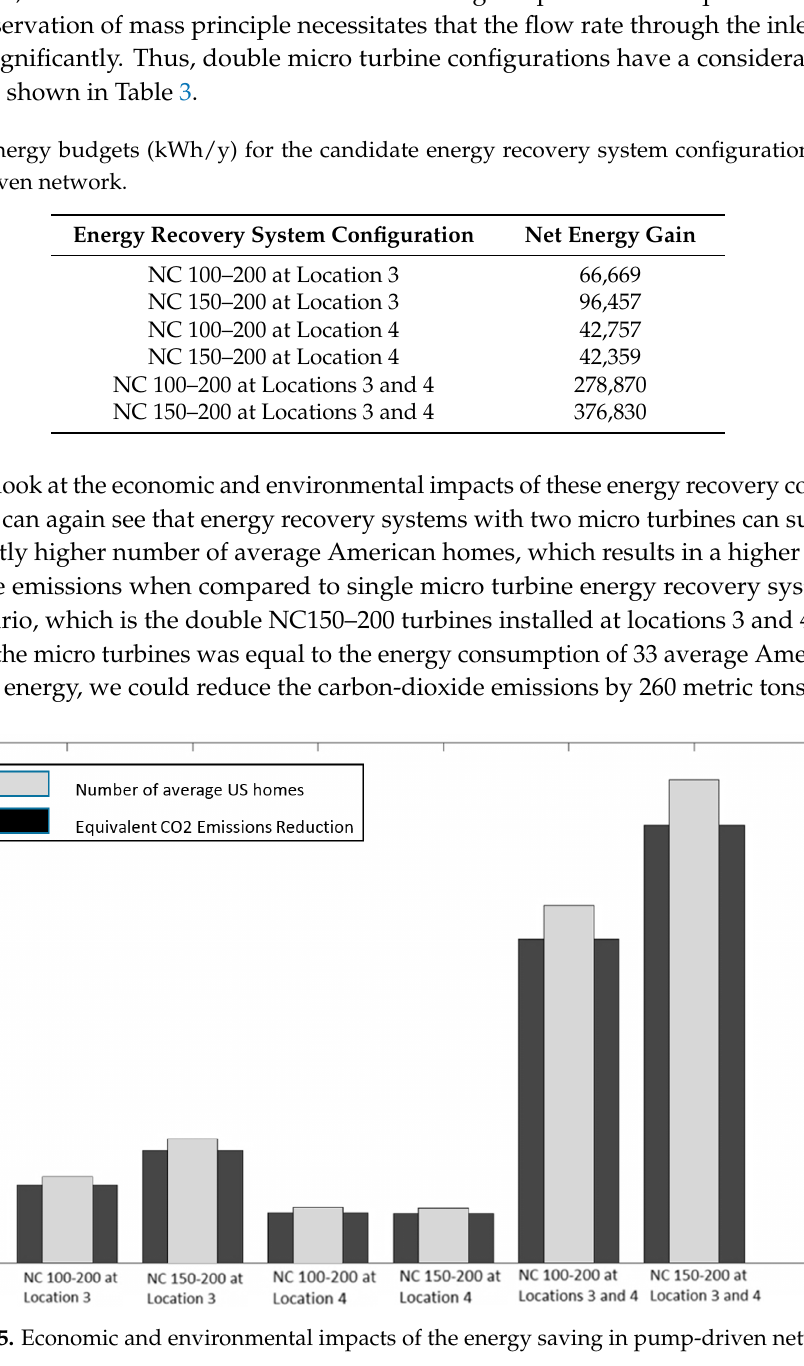
Figure 15. Economic and environmental impacts of the energy saving in pump-driven network.